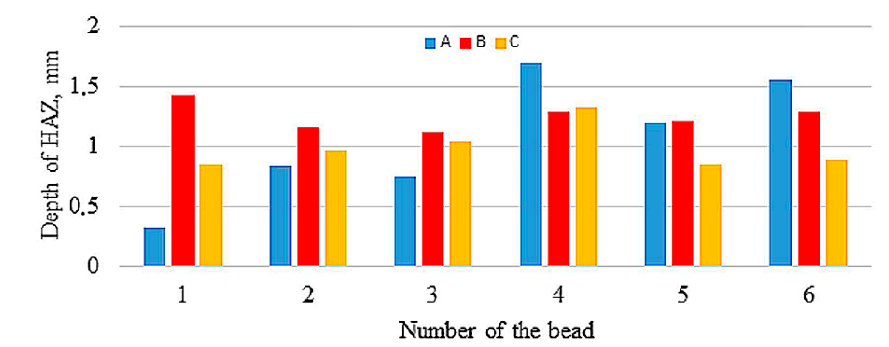
Figure 5. Heat-Affected Zone (HAZ) depth of particular beads.